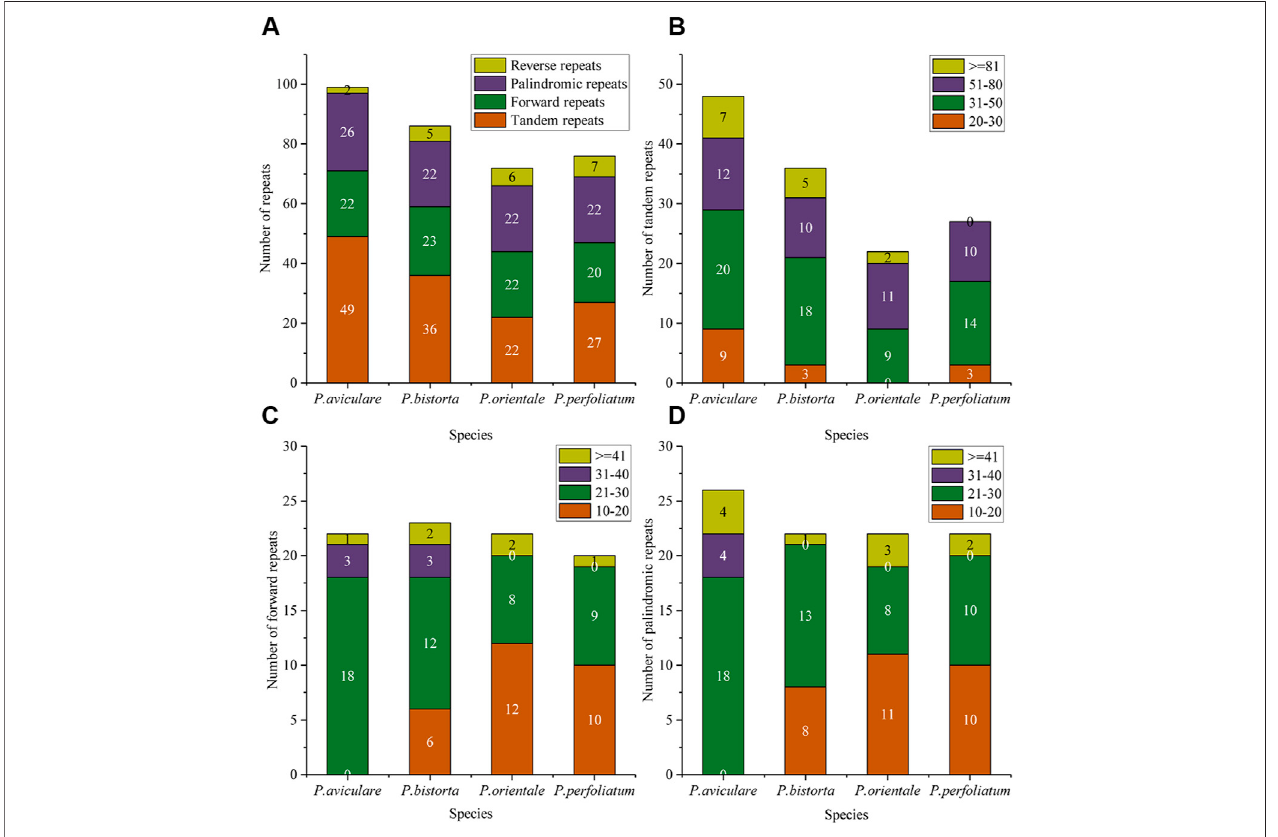
FIGURE2| Repeat sequences analysisofthefour Polygonum cpgenomes. (A) Repeat typesinthefour cpgenomes; (B) tandem repeatsinthefour cpgenomes; (C) forward repeats inthe four cpgenomes; (D) palindromicrepeats in thefour cpgenomes. In (A) , different colorsshow different repeattypes; in (B – D) ,differentcolors show different lengths. The ordinate represents the number of repeats.